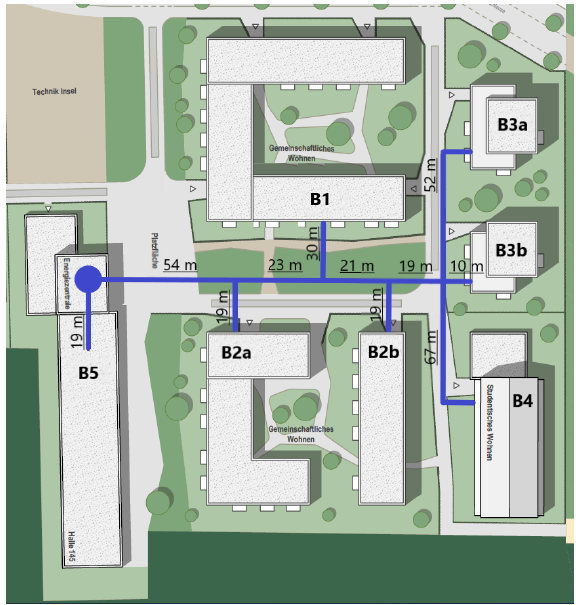
Figure 2. ENaQ district heating system (Figure obtained from GSG Oldenburg (Germany)).